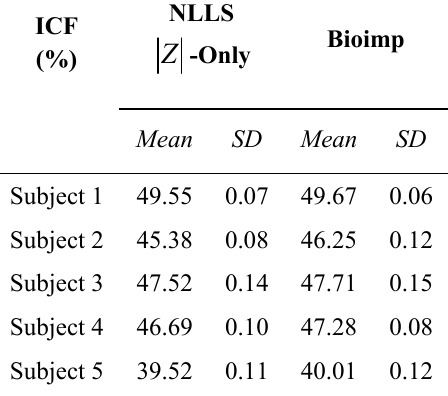
Fig. 4 Mean, minimum and maximum values for ICF, in %, estimated for all the subjects with both methods